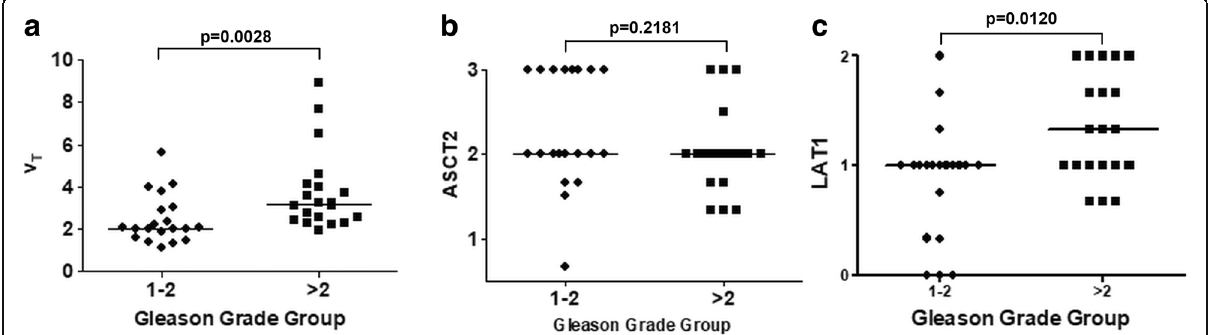
Fig. 4 Correlation between 18 F-fluciclovine distribution volume ( V T ), amino acid transporter expression (ASCT2/LAT1 staining intensities), and Gleason grade groups (GGG). On the x -axis, GGG ≤ 2 and GGG>2 are shown separately P -values are shown for the differences between GGG ≤ 2 and